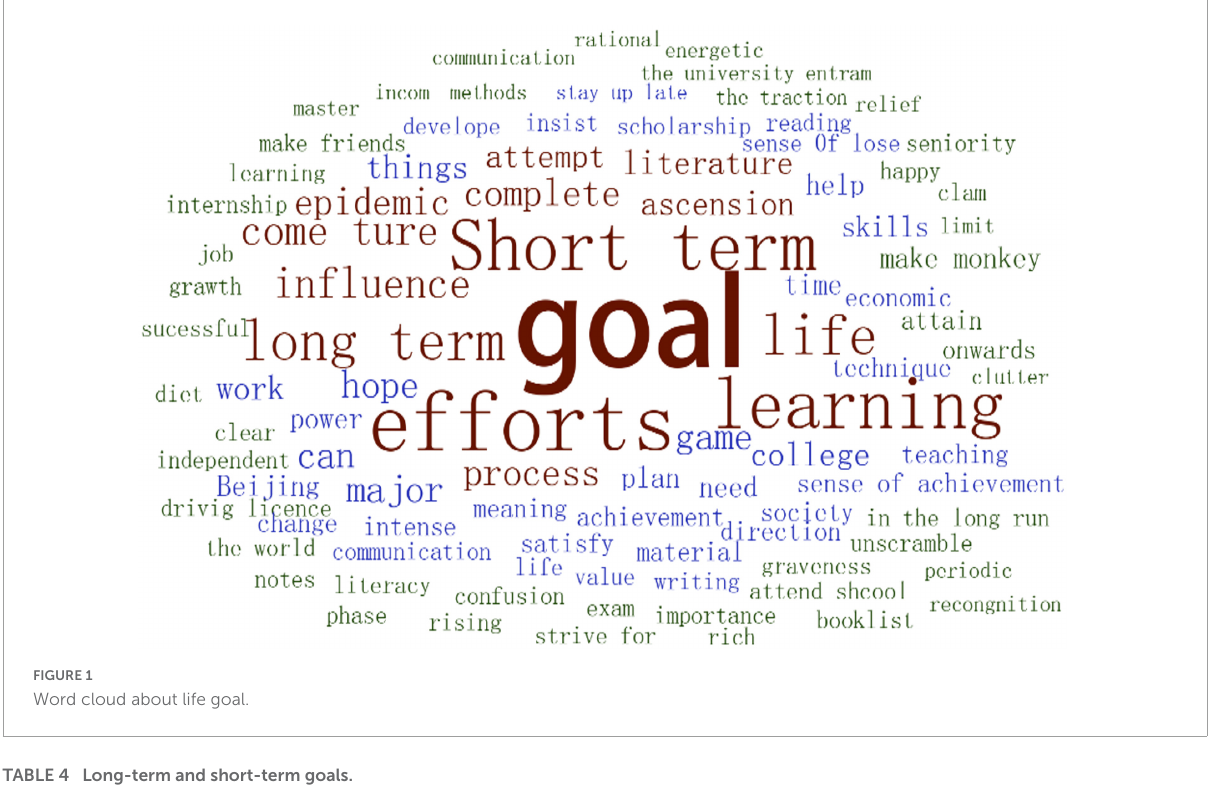
TABLE 4 Long-term and short-term